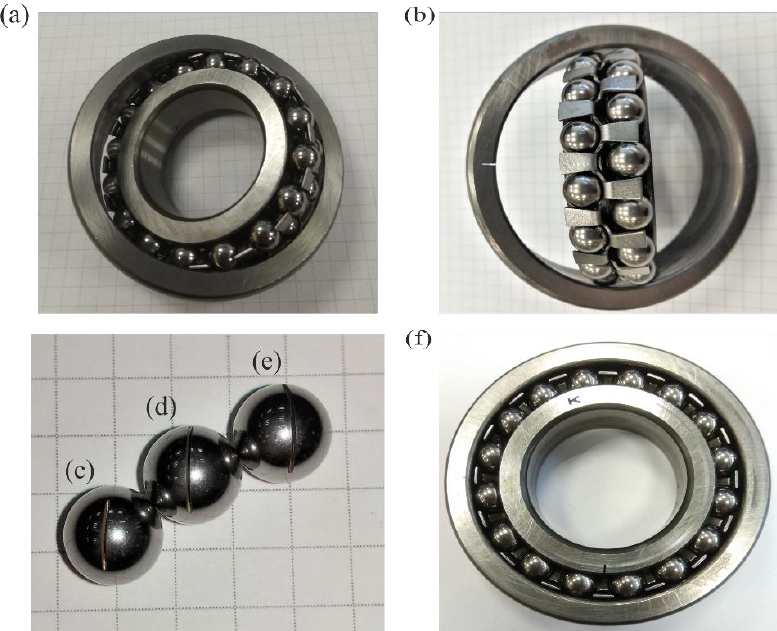
Figure 3. Ball bearing SKF 1207K: ( a ) undamaged; ( b ) with cut outer race; with the cut ball at the depthof: ( c ) 1 mm; ( d ) 2 mm; ( e ) 3 mm; ( f ) with cut inner race.